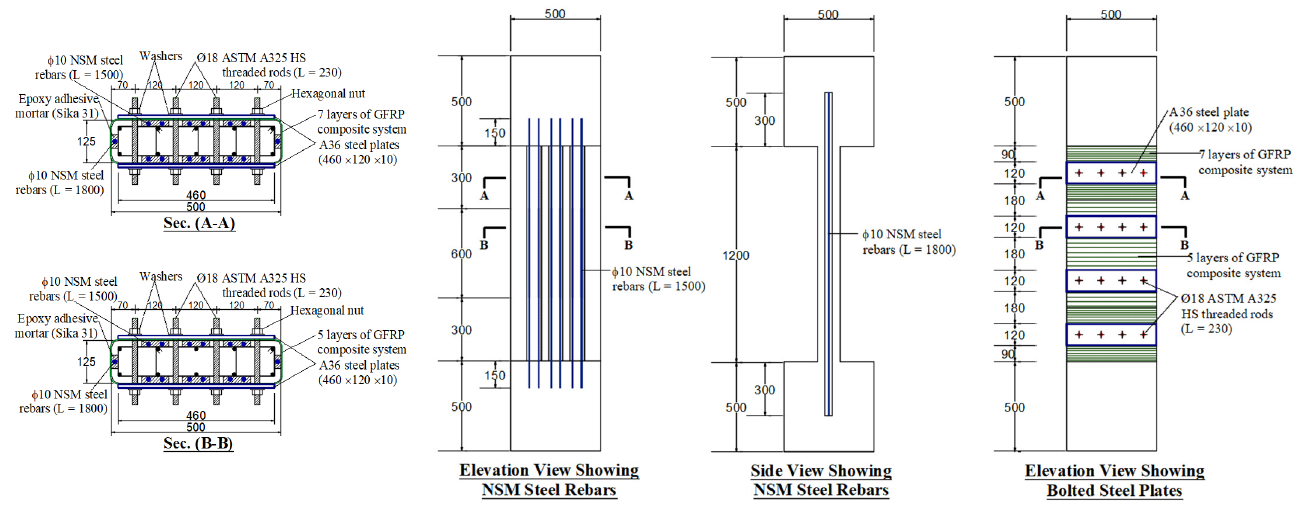
Figure 4. Details of strengthened column S3 (units of dimensions = mm).